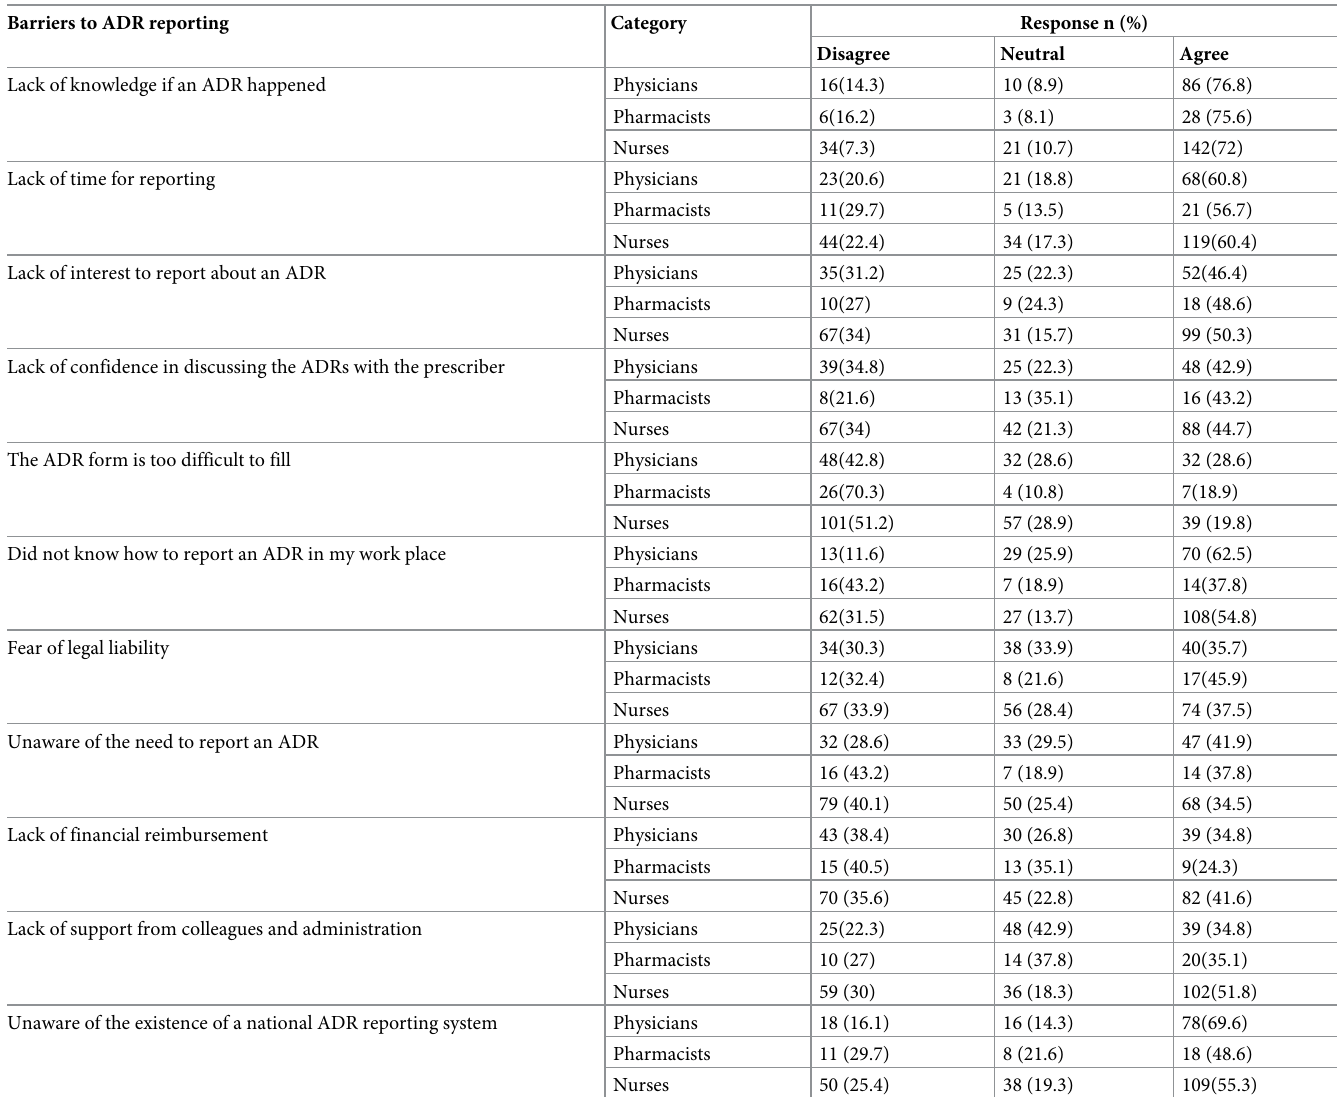
Table 2. Barriers to ADR reporting by